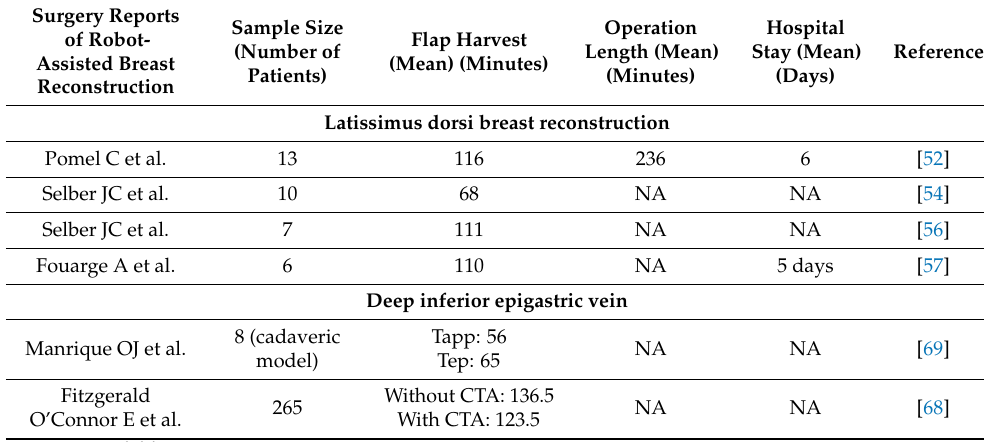
Table 2. Various studies pertinent to flap harvest, surgical operation length (in terms of time of operation), and overall hospital stay during robot-assisted breast